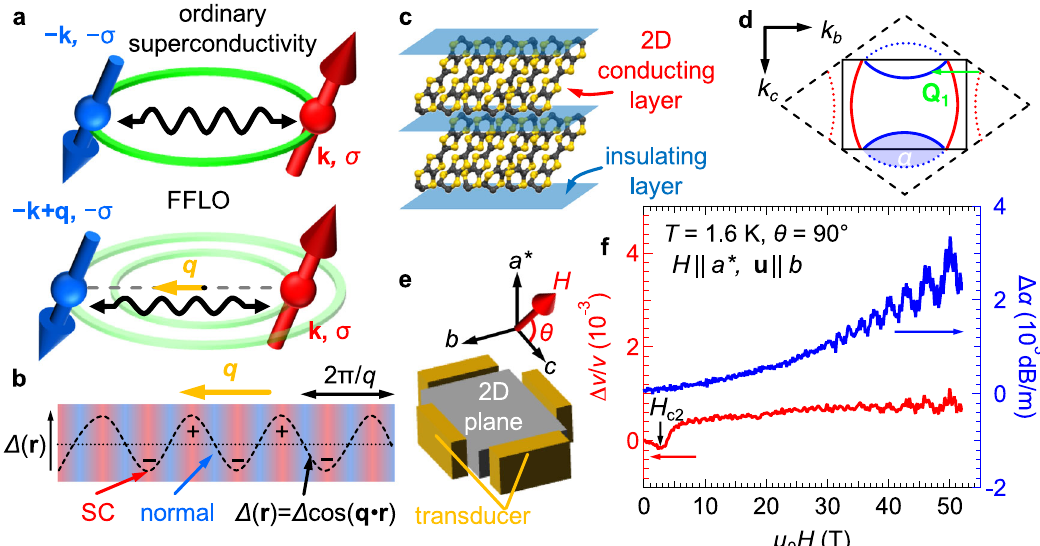
Fig.1|SchematicsoftheFFLOstate,crystalstructure,andexperimentalsetup. a Schematicsofordinaryspin-singletpairingandFFLOpairing.kand σ representthe momentum and spin of the electrons. b Spatial modulation of order parameter Δ ( r ) in the FFLO state (dashed curve). The normal state (blue) appears at nodes of the superconducting order parameter Δ cos( qr ). c Quasi-two-dimensional crystal struc- ture of κ -(BEDT-TTF) 2 Cu(NCS) 2 . d Fermi surface of κ -(BEDT-TTF) 2 Cu(NCS) 2 . The solid and dashed black lines are the fi rst Brillouin zone and the extended Brillouin